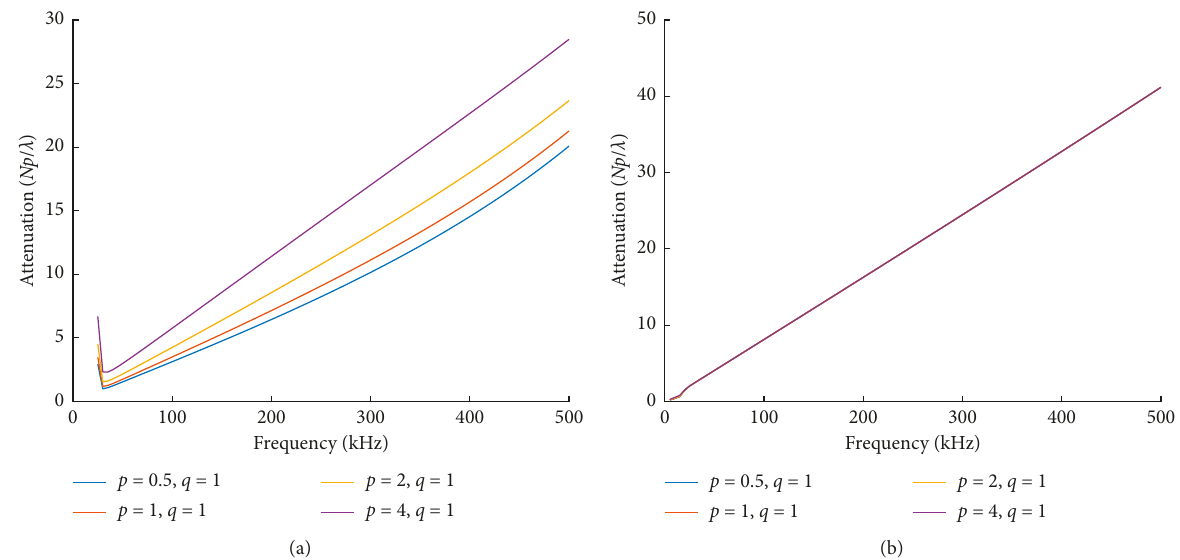
Figure 5: Attenuation curves of guided wave, p � 0.5, 1, 2, and 4. (a) Attenuation curves of L ( 0 , 2 ) . (b) Attenuation curves of T ( 0 , 1 )